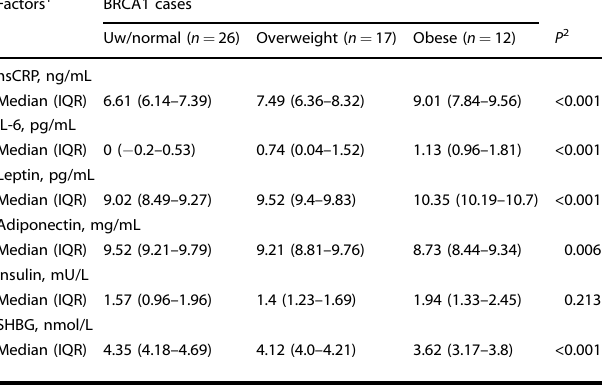
Table 2. Measured blood factors strati fi ed by body mass index. Table 3. Correlations among blood biomarkers, BMI, and breast